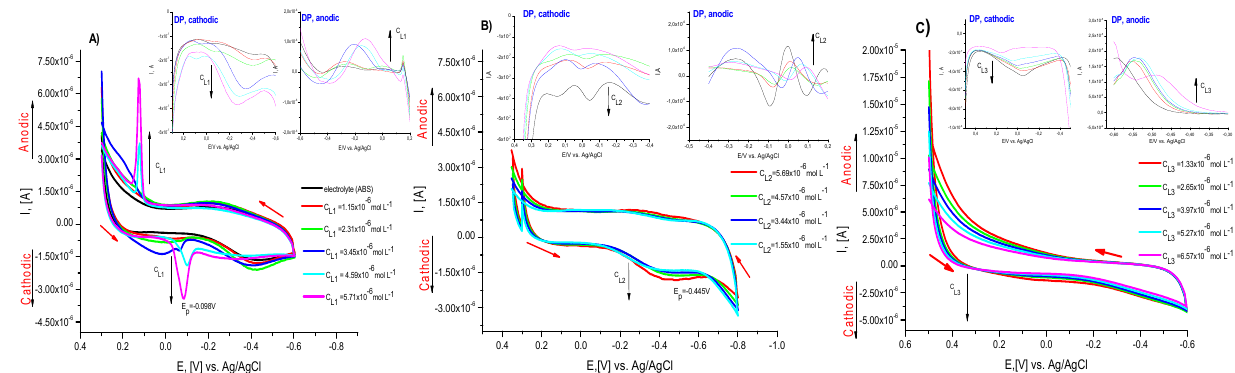
Figure 10. Ciclyc voltamperograms and differential pulse voltamperograms (inserted graphics) of investigated azo-azomethine derivatives ( A ) N-AMP1; ( B ) N-AMP2 and ( C ) N-AMP3 in ammonium (pH 10.35, 0.1 mol L − 1 ) buffer solutions at Pt working electrode and Ag/AgCl, KCl (3 mol L − 1 ) as reference electrode; scan rate: 1.00 V s − 1 .